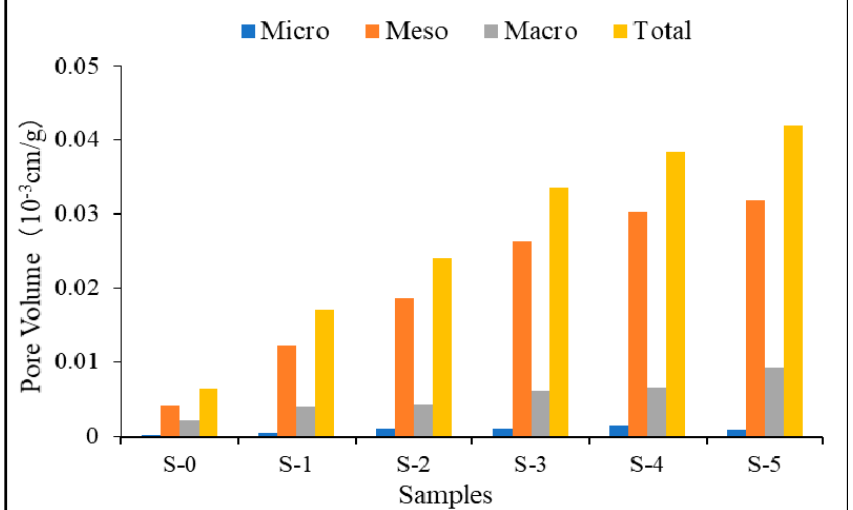
Figure 7. Pore volumes of six shale samples.